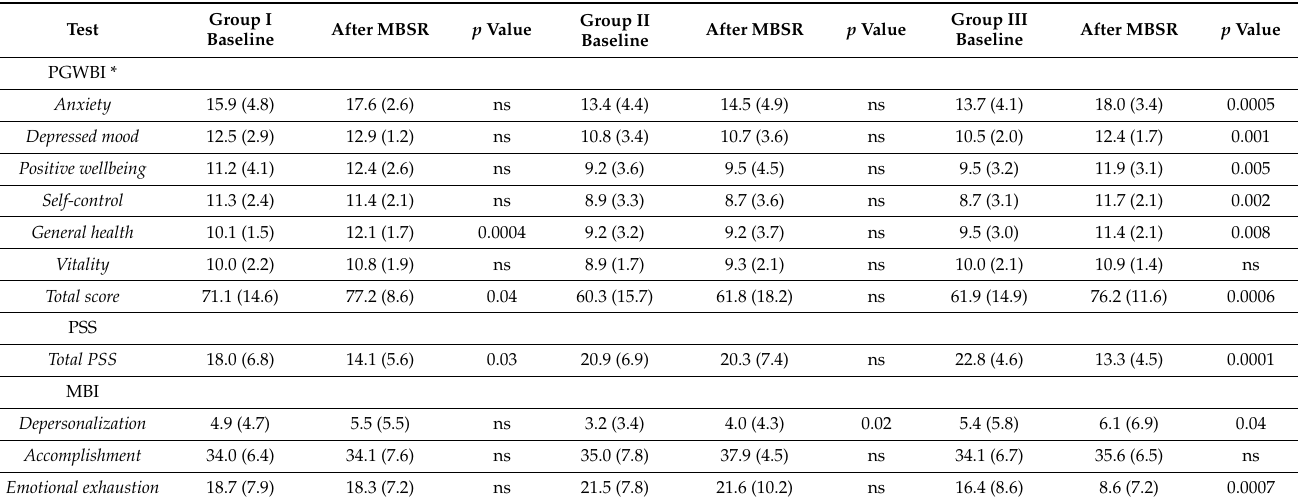
Table 2. Values of psychometric domains and total scores in Groups I, II and III before and after the MBSR